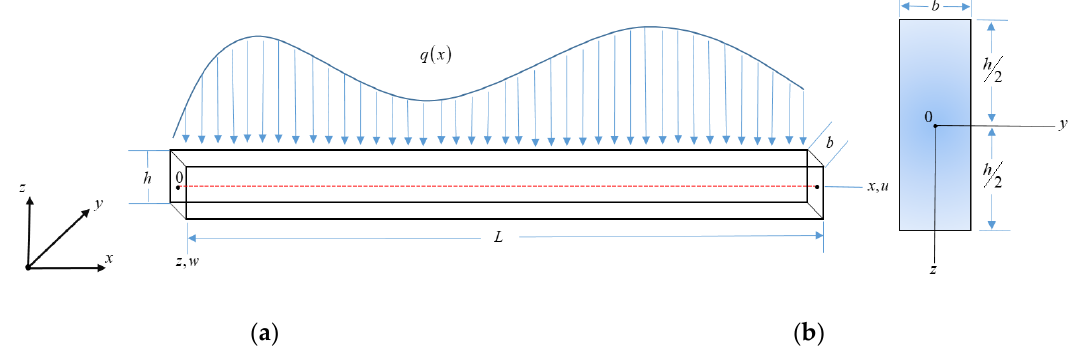
− plane; ( b ) Cross-section of beam in y z